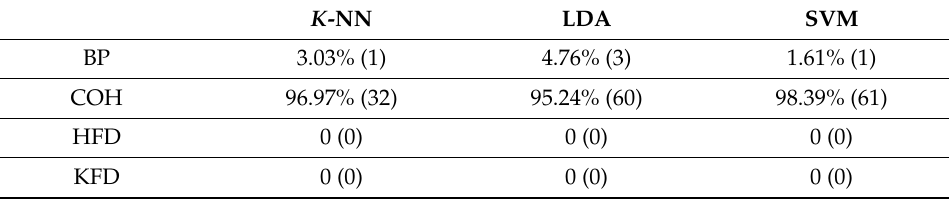
Figure 5. Plots of classification accuracy (vertical) versus the number of features determined by the SBS-based feature selection procedure (horizontal). The solid curves represent the MDD-HC classification accuracy obtained by performing the 5-fold cross validation on the training set using different classifiers. The dotted curves represent the classification accuracy on the test set. Table 5. The numbers and the percentages of BP, COH, HFD, and KFD in the optimal feature subset for each